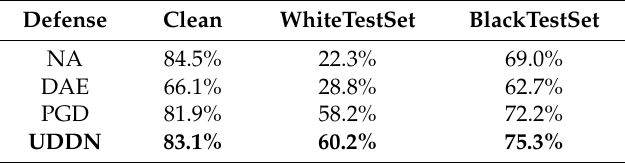
Table 2. The accuracy of model with different denoising methods on the test datasets.